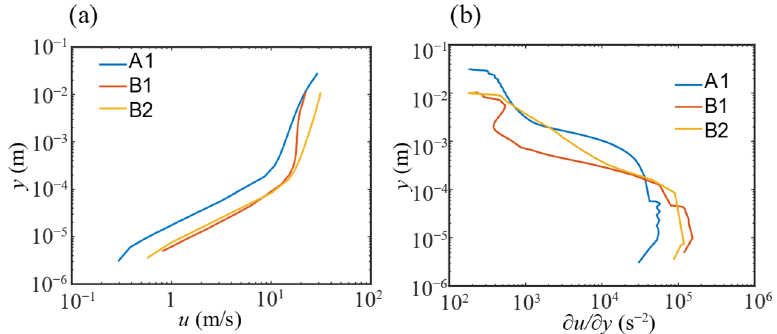
Figure 12. Comparison of the velocity profiles ( a ) and the velocity gradients ( b ) in the boundary layer at the DP system inlet of A1, B1, and B2.